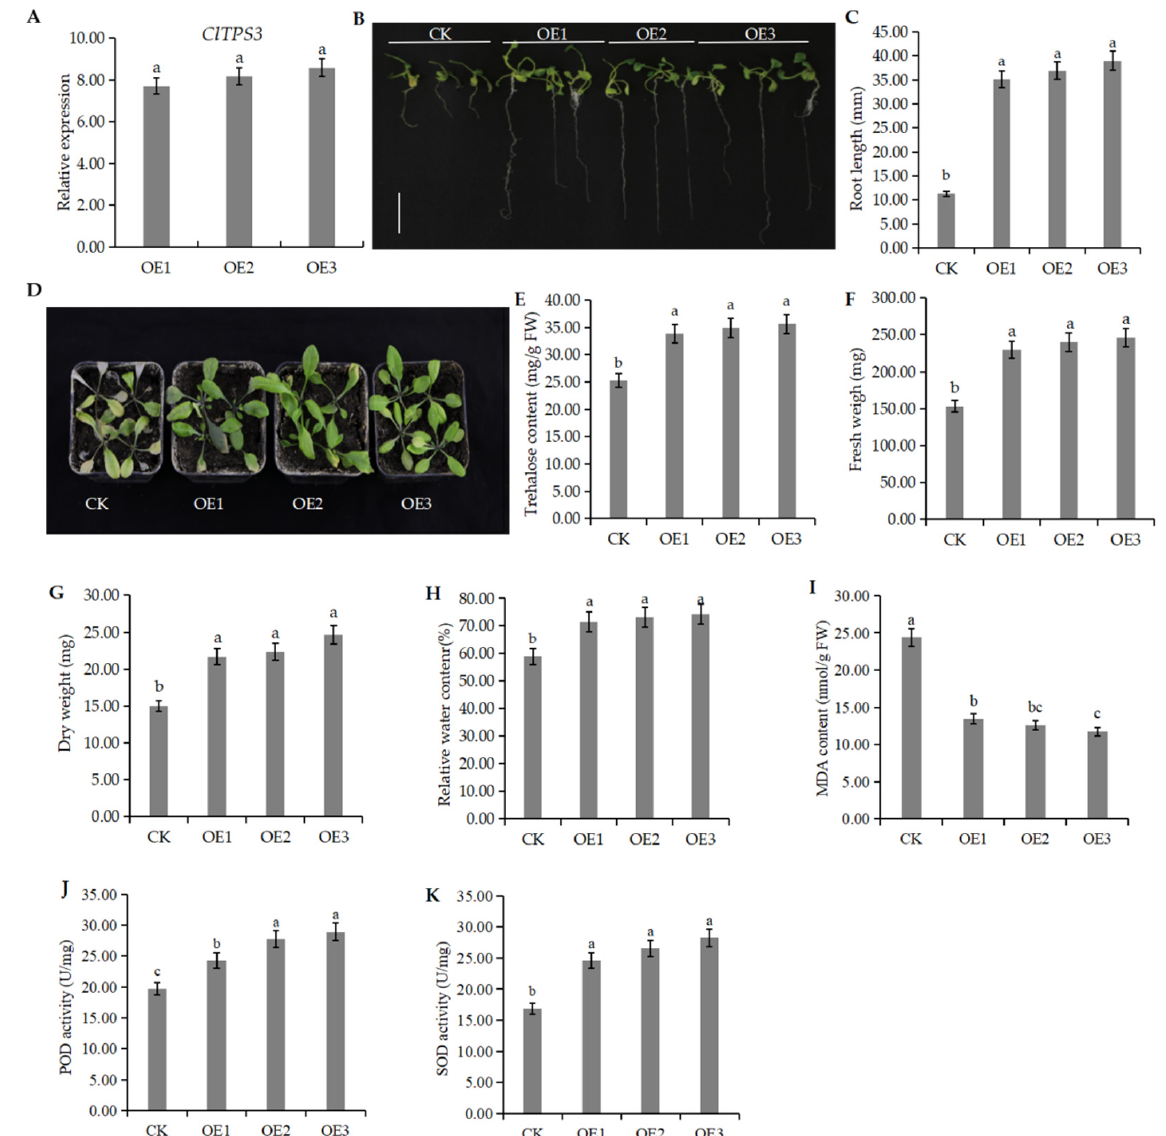
Figure 8. Phenotypic analysis of ClTPS3 overexpressed A.thaliana plants. ( A ) The expression level of ClTPS3 in different A.thaliana lines. ( B ) The growth status of wild type and transgenic seedlings under 200 mM NaCl stress, the white scale range represents 1 cm. ( C ) The root length of different A.thaliana lines under 200 mM NaCl stress. ( D ) The growth status of different A.thaliana lines adult plant under 200 mM NaCl stress. ( E ) Trehalose content of different A.thaliana lines. ( F ) Fresh weight, ( G ) dry weight, ( H ) relative water content, ( I ) MDA content, ( J ) POD activity and ( K ) SOD activity of different A.thaliana lines under 200 mM NaCl stress. CK represents wild-type A. thaliana plants, and OE1, OE2, and OE3 are transgenic A. thaliana plants. Error bars indicate the SD of three biological replicates. Different letters indicate significant differences within treatments by ANOVA ( p <